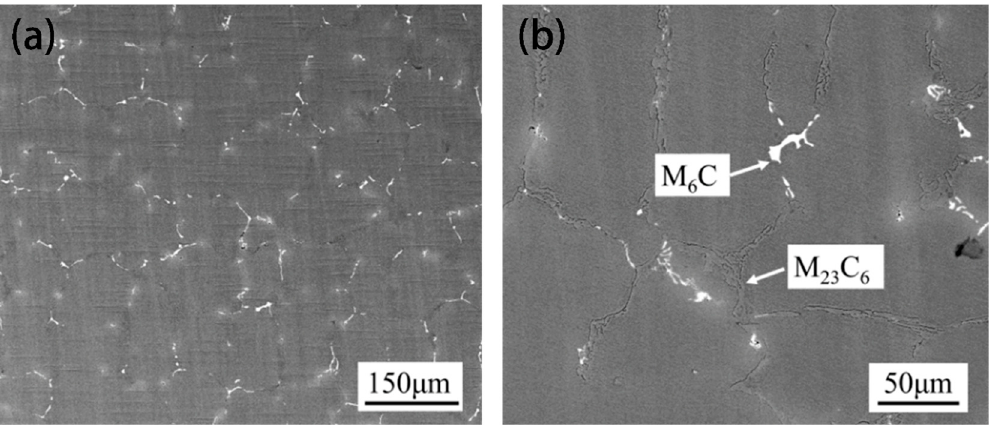
Figure 3. Typical microstructure of DZ40M in aged state: ( a )integral view; ( b ) proeutectoid carbide.